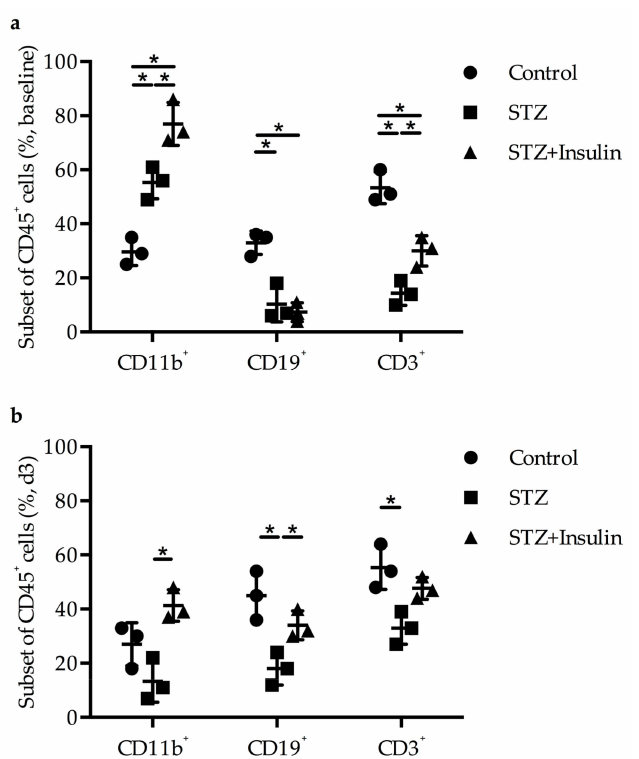
Figure 4. Dot plots represent the results of FACS analyses on CD11b + , CD19 + , and CD3 + cells performed on ( a ) whole blood of control, STZ, and STZ + insulin-treated mice without any surgical treatment and on ( b ) adductor muscles isolated from mice 3 days post-FAL ( a , b : n = 3 per group, each group compared to each other group using a two-way ANOVA with Bonferroni’s multiple comparison